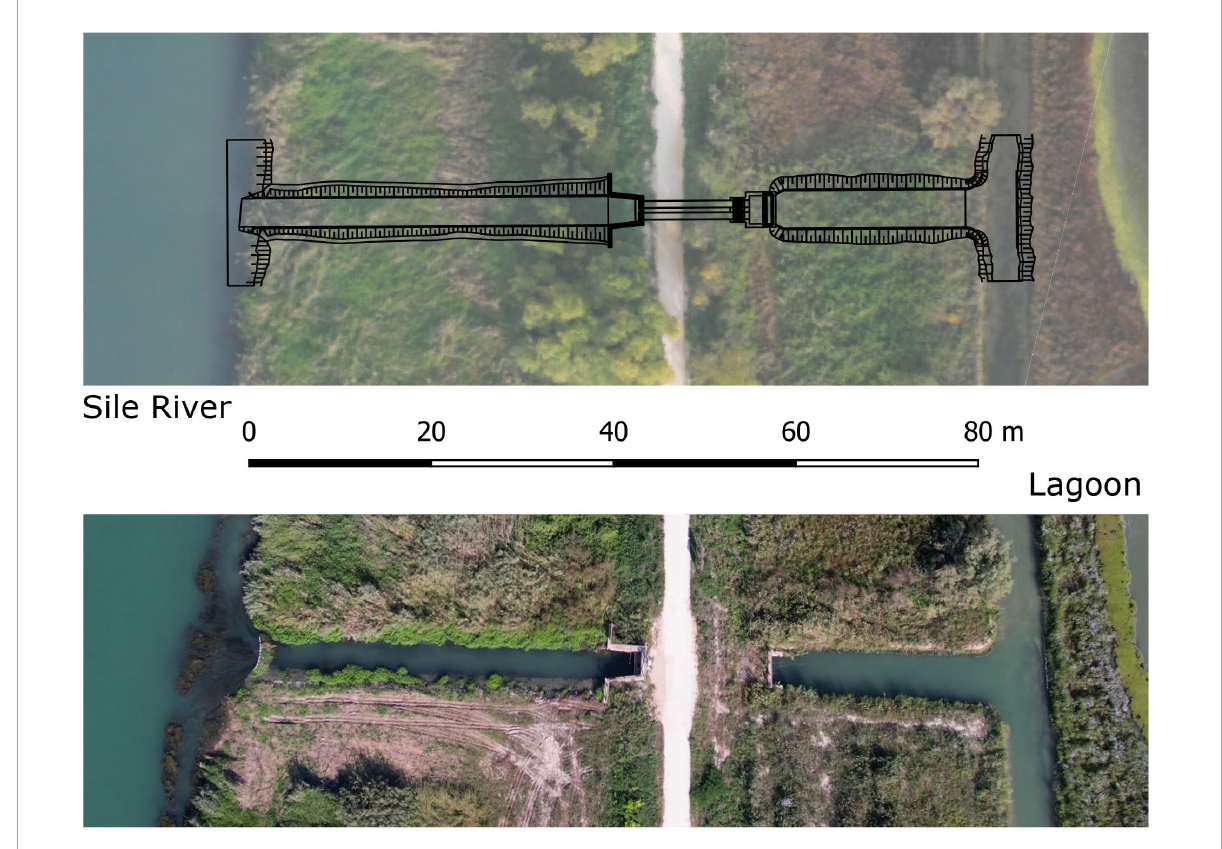
FIGURE4 Hydraulic works. Top : executive design; bottom : completed hydraulic works.